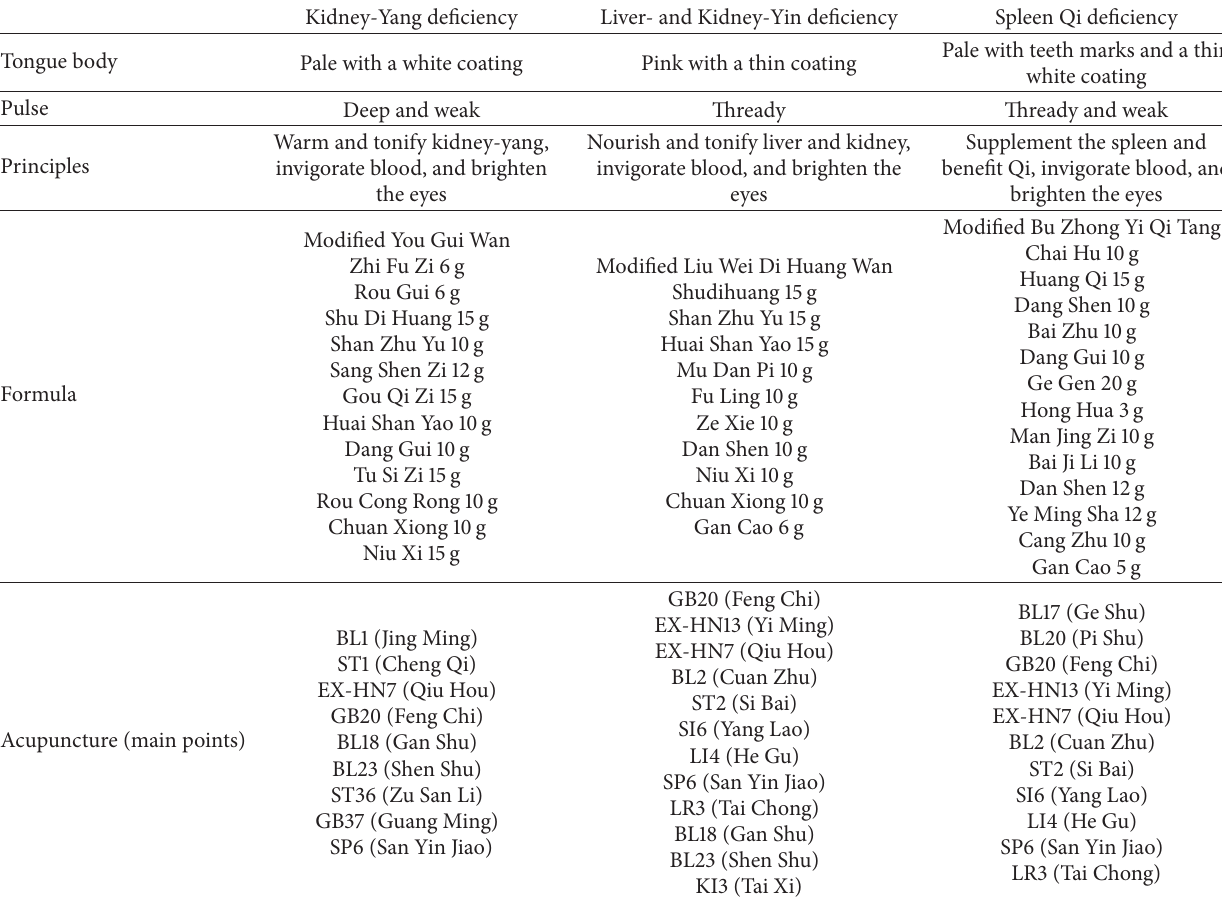
Table 1: Common clinical patterns and clinical treatments in TCM. Kidney-Yang deficiency Liver- and Kidney-Yin